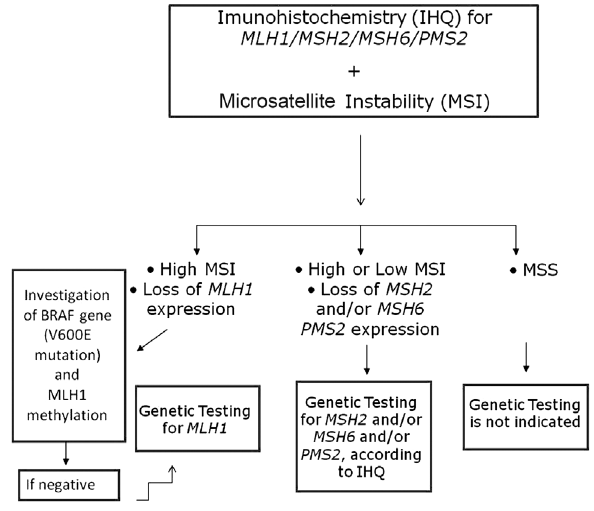
Figure 3 - Flowchart illustrating the strategy utilized for genetic testing of patients at risk for Lynch Syndrome (flowchart adapted from Hampel et al. ,